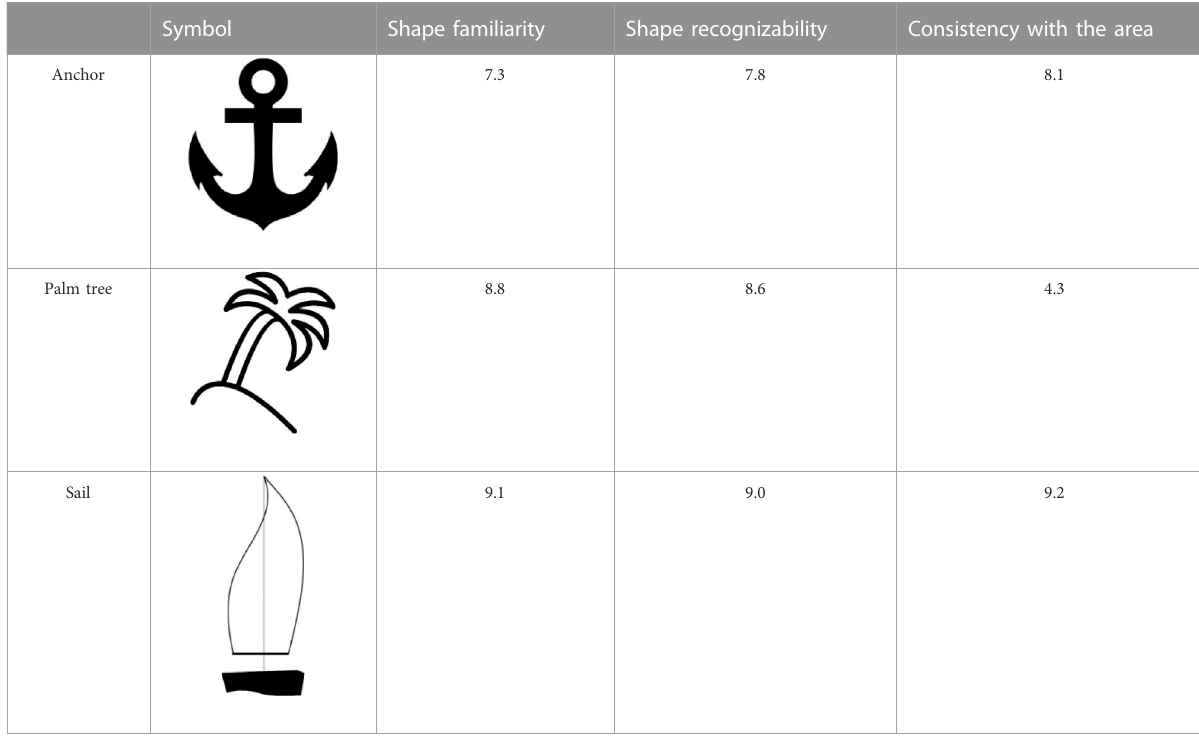
TABLE 1 Results of the survey on symbolic elements for Italian territorial